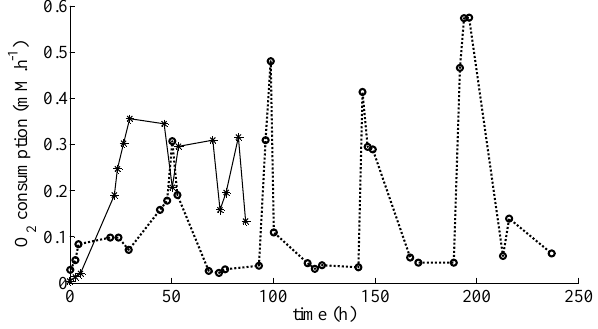
Fig. 2. Dynamics of O 2 consumption (mMh − 1 ) as calculated from the decrease in O 2 concentration with an oxygraph at each sam- pling time during 200s for the SA (*) and the P ( (cid:13) ) experiment. Data points are connected by solid and dotted lines for the SA and P experiment,